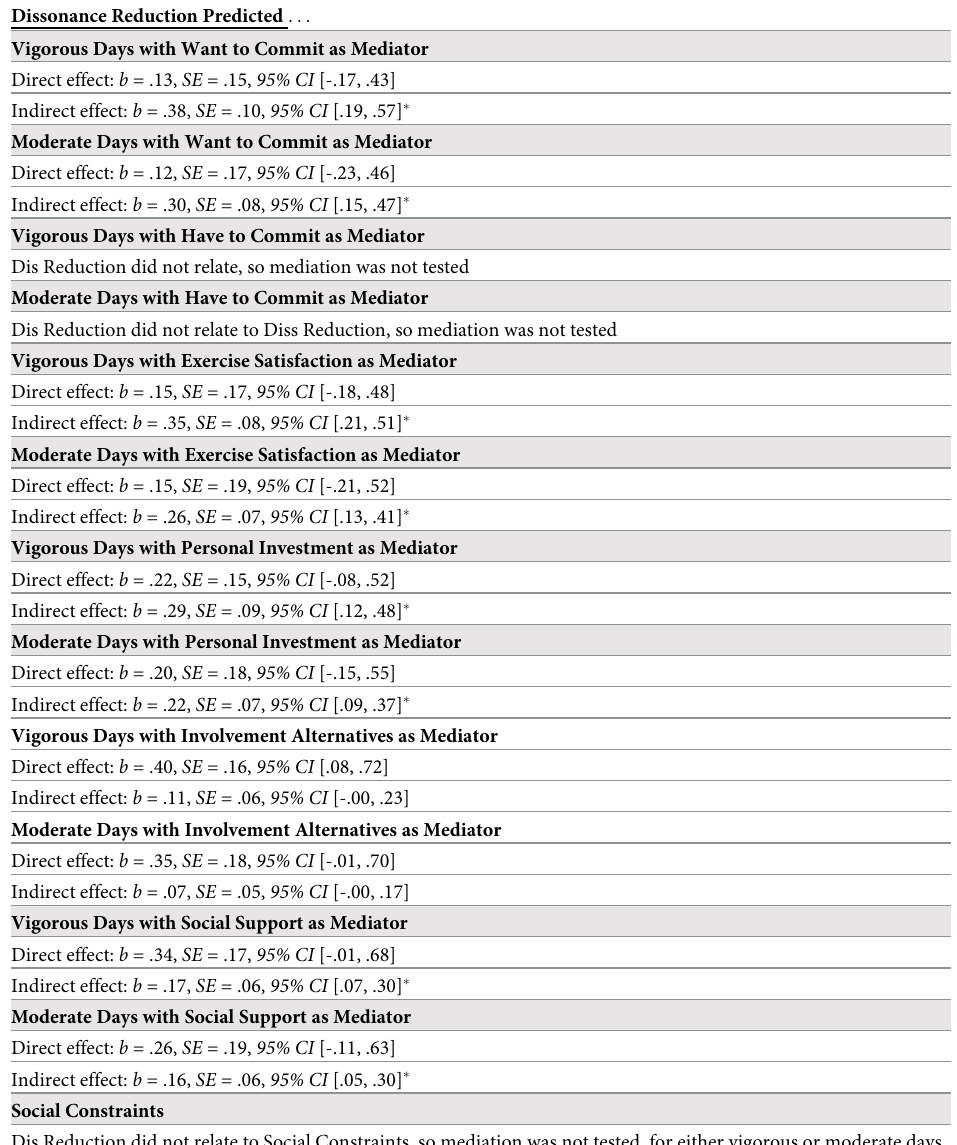
Table 19. Mediational analyses for dissonance reduction and days of exercise (Study 3). Dissonance Reduction Predicted